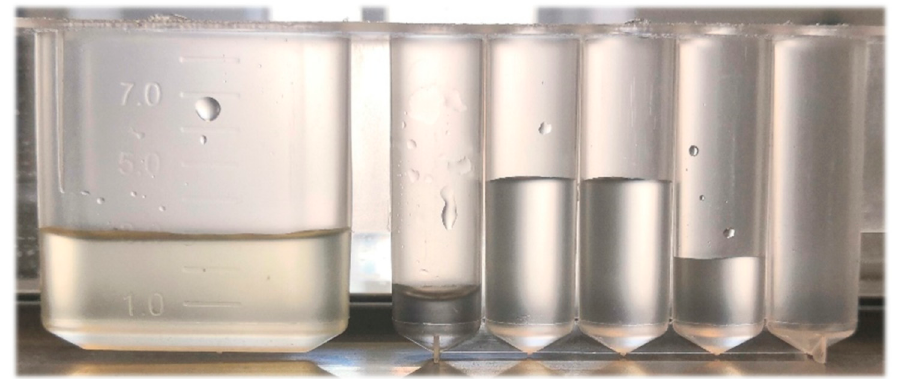
Figure 5. The states in each well of the kit after the clean-up procedure with MBs. From left to right: sample well (yellow and muddy), MB well, two washing wells, and elution well (limpid).